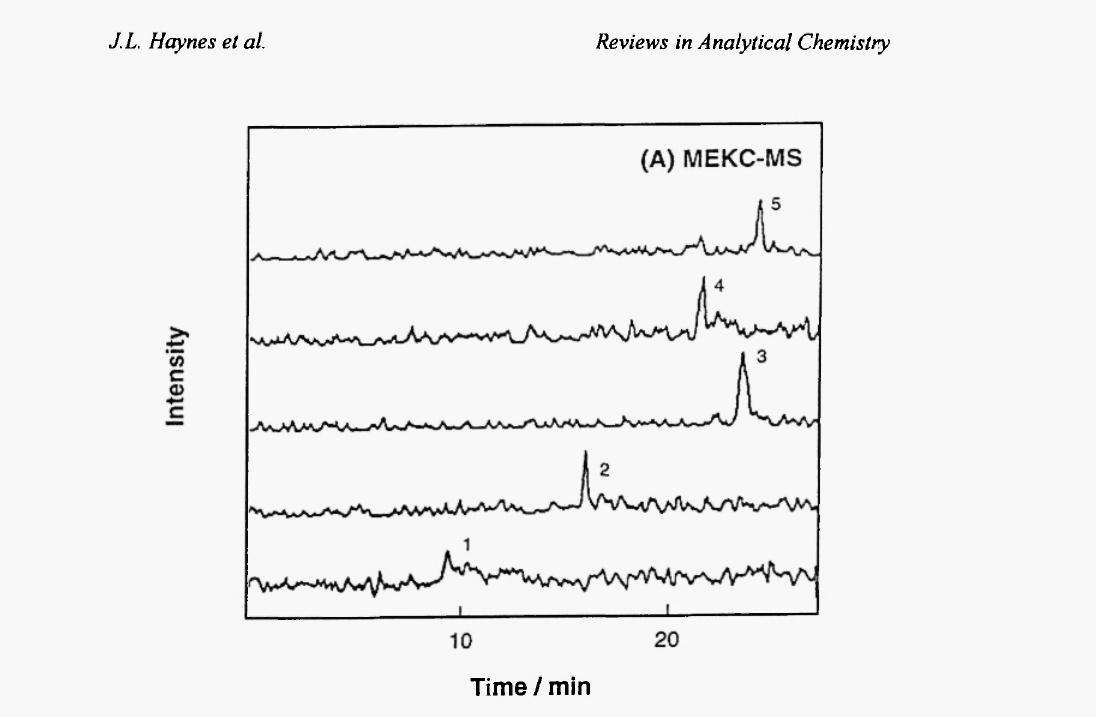
T i m e / m in Fig. 32: Single-ion chromatograms obtained by MEKC-ESI-MS. Solutes: 1 = phenyltrimethylammonium chloride; 2 = 1-naphthylamine; 3 = quinine sulfate; 4 = tetraphenylphosphonium chloride; 5 = oxta- oxyethylenedodecanol. Conditions: electrospray voltage, 3 kV; MS scanning, from m/z 1 to 1000 at 4 per scan; drift voltage, 70 V; focusing voltage, 140 V; resolution, 55; sheath liquid flow, water-methanol-formic acid (50:50:1, v/v/v) at ca. 5 μΐ/min; sample solutions were introduced by syringe injection. From /81/ with